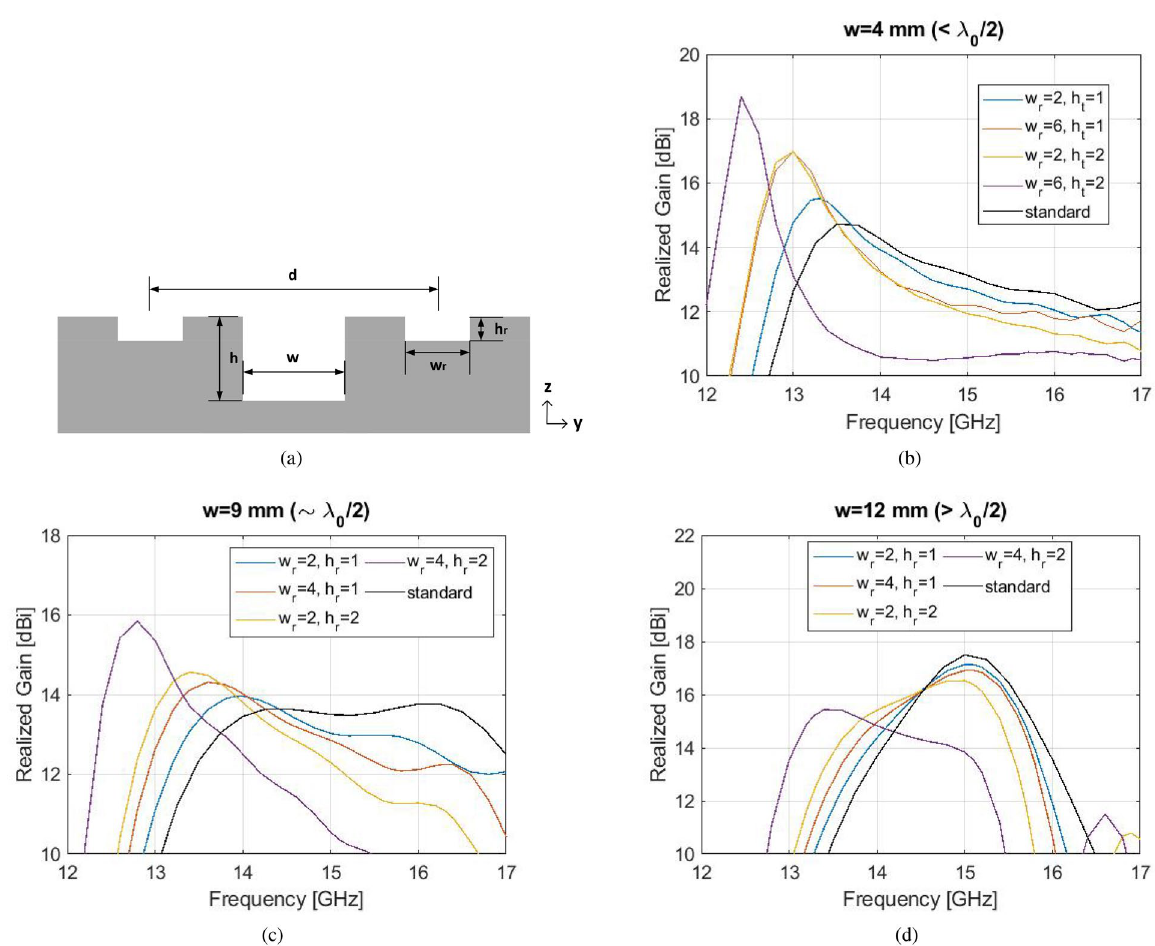
Figure 4. ( a ) Cross section of the double corrugated unit cell. Simulated realized gain of the double corrugated antenna with N = 6 when ( b ) w < (cid:31) 0 / 2 , ( c ) w ∼ (cid:31) 0 / 2 , ( d ) w > (cid:31) 0 / 2 . Dimensions are in